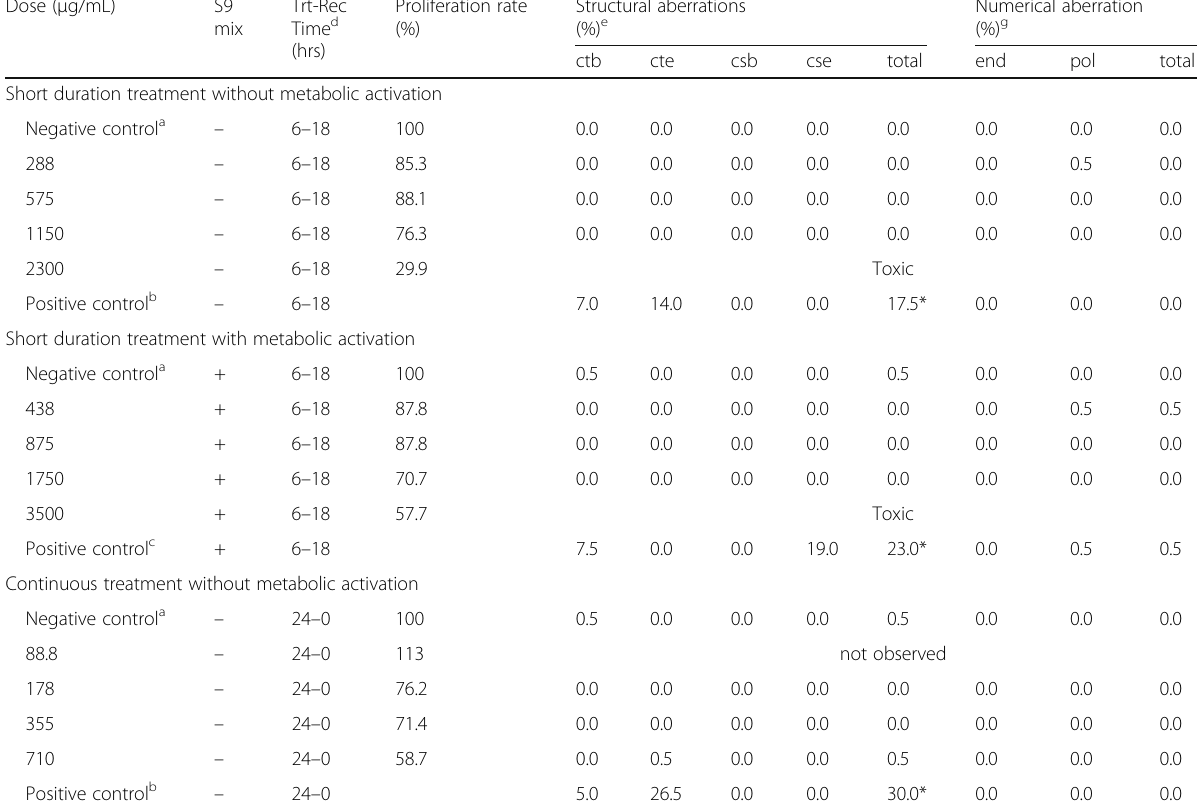
Table 2 Results of the in vitro chromosomal aberration test for SOCG Dose ( μ g/mL)